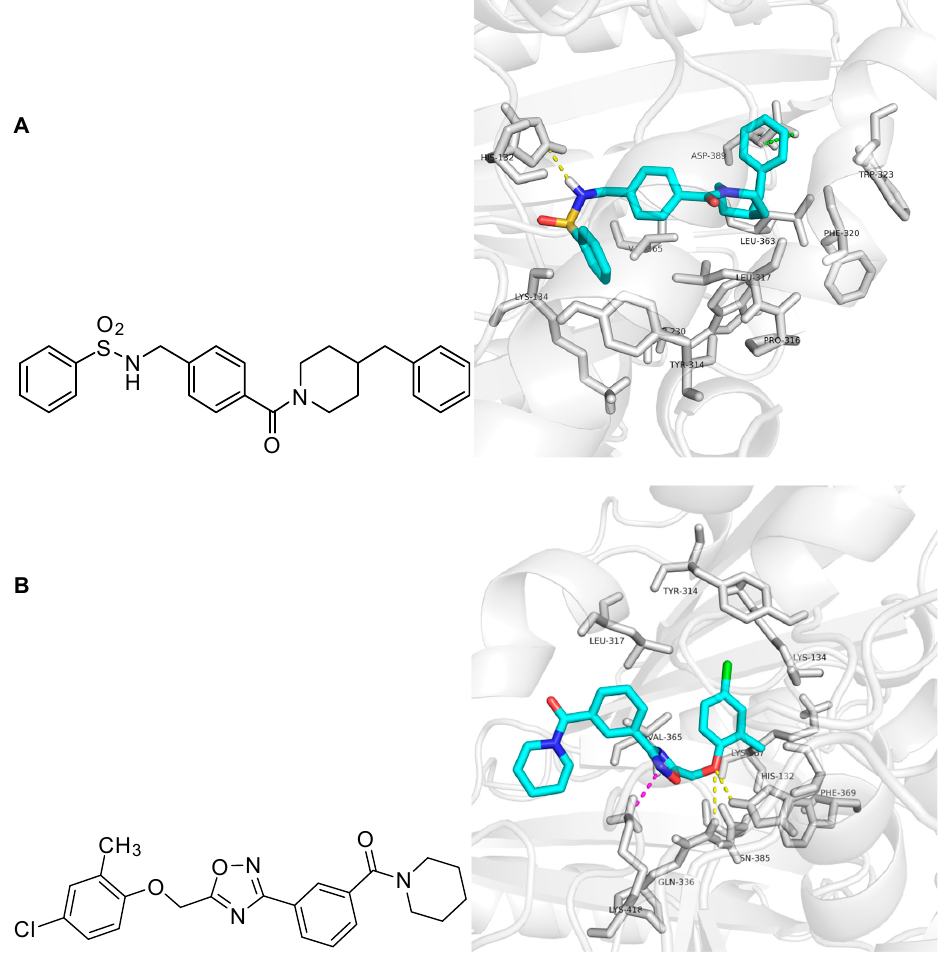
Figure 5. Docking study of ZINC09833455 and ZINC32996629 in DprE1 shown by Pymol 0.99. Panel ( A ): Chemical structure and molecular modeling of ZINC09833455. ZINC09833455 is shown as the cyan stick structure and the surrounding residues are gray. Hydrogen bond interactions are yellow dotted lines and anion- π interactions are green dotted lines; Panel ( B ): Chemical structure and molecular modeling of ZINC32996629. ZINC32996629 is shown as the cyan stick structure and the surrounding residues are gray. Hydrogen bond interactions are yellow dotted lines and cation- π interactions are purple dotted lines.